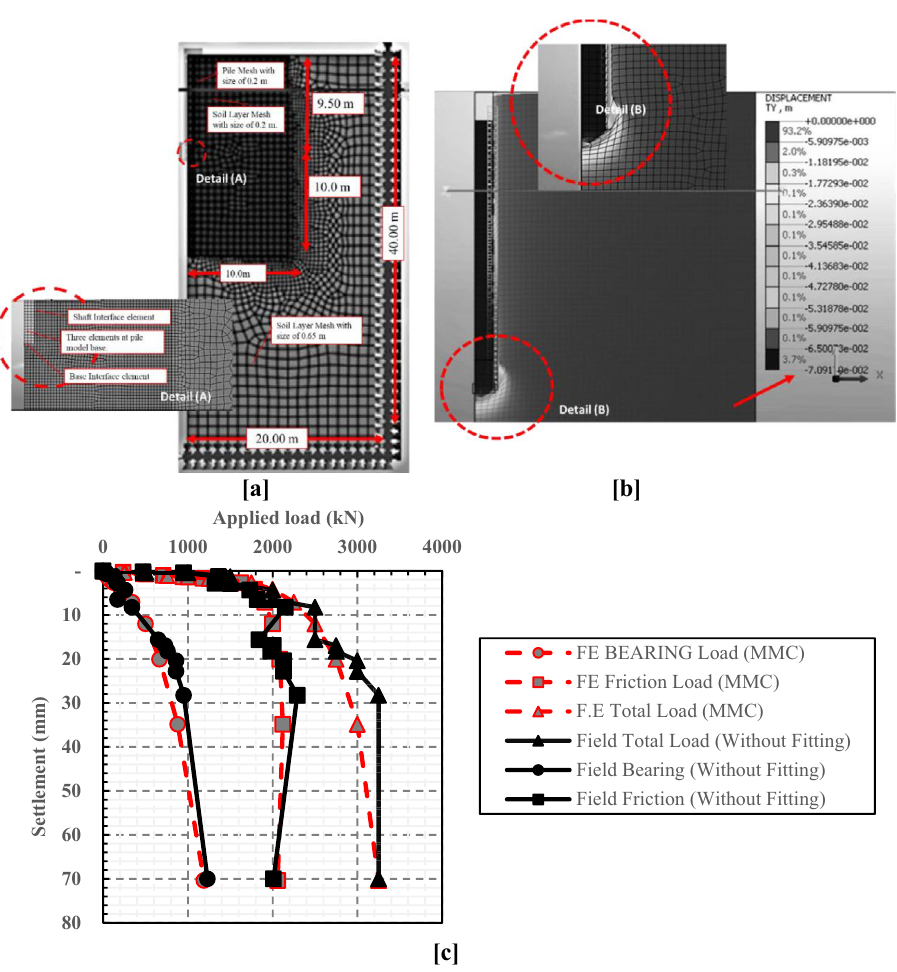
Figure 2. Numerical model established to simulate the response of the LDBP of the Alzey bridge case history (After Al-Atroush et al. 32 ). ( a ) Details of boundary conditions. ( b ) Deformed shape of the finite element mesh under the Failure load. ( c ) Comparison between field measurements and the numerical